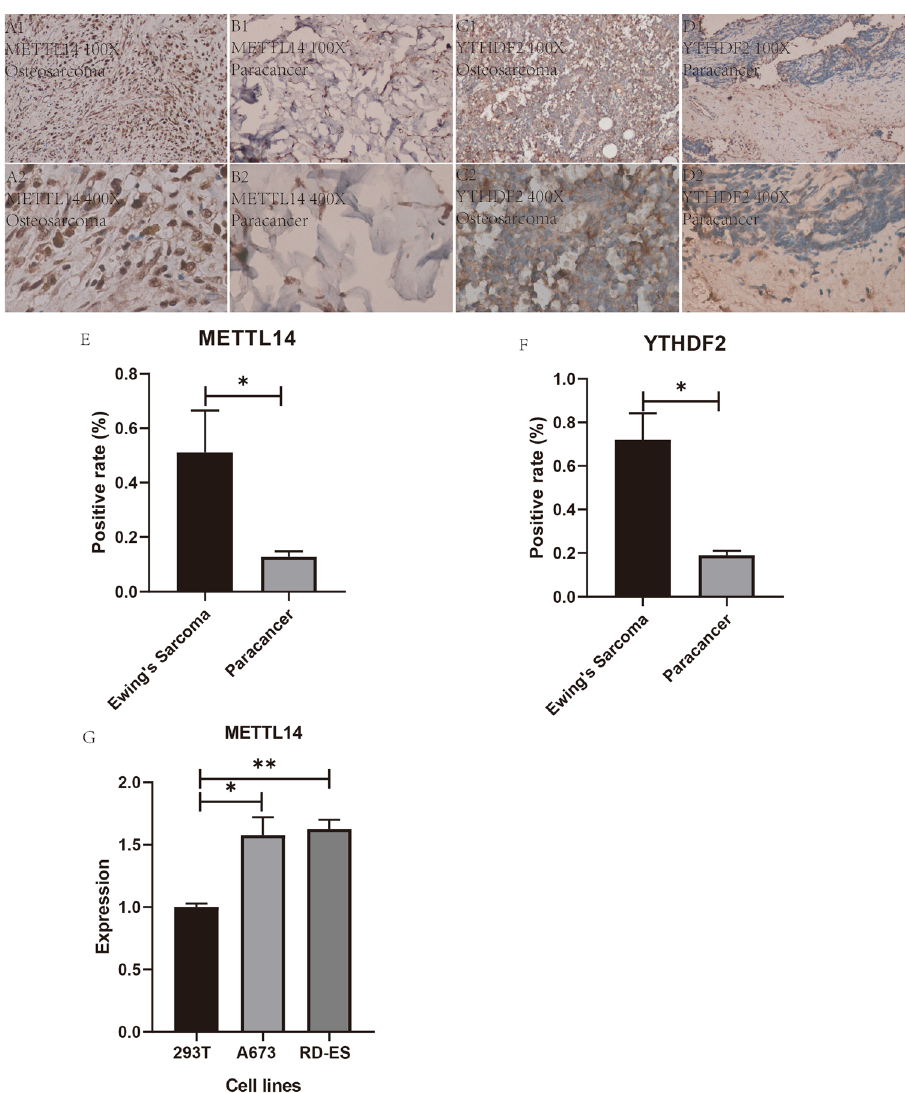
Figure 11. Immunohistochemistry, positivity statistics and qRT-PCR results. ( A1 , A2 , B1 , B2 ) represent immunohistochemical specific staining maps of METTL14 in Ewing’s sarcoma tissue and in paraneoplastic tissue at 100× magnification and 400× magnification. ( C1 , C2 , D1 , D2 ) represent immunohistochemical specific staining maps of YTHDF2 in Ewing’s sarcoma tissue and in paraneoplastic tissue at 100× magnification and 400× magnification. ( E ) indicates the statistical plot of the positive rate of immunohistochemistry for METTL14. Figure F represents the statistical graph of the positive rate of immunohistochemistry for YHHDF2, "*" indicates P < 0.05. ( G ) shows the expression of METTL14 in two Ewing’s sarcoma cell lines and one control cell line, which can be found to be significantly different in ES and control."*" indicates P < 0.05. "**" indicates P <